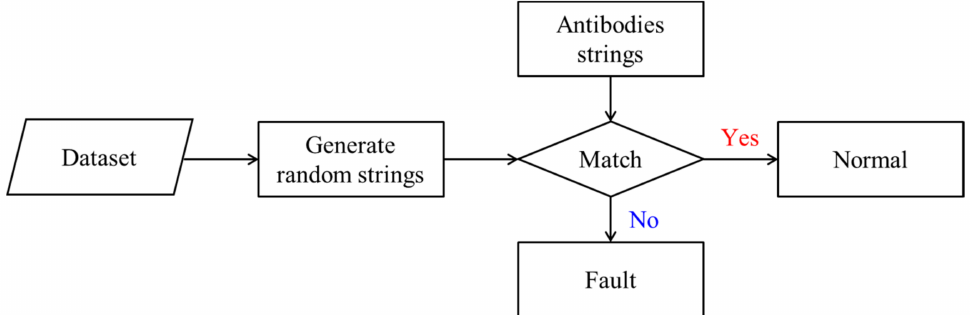
Figure 2. Classification using the negative selection (NS) algorithm flowchart.